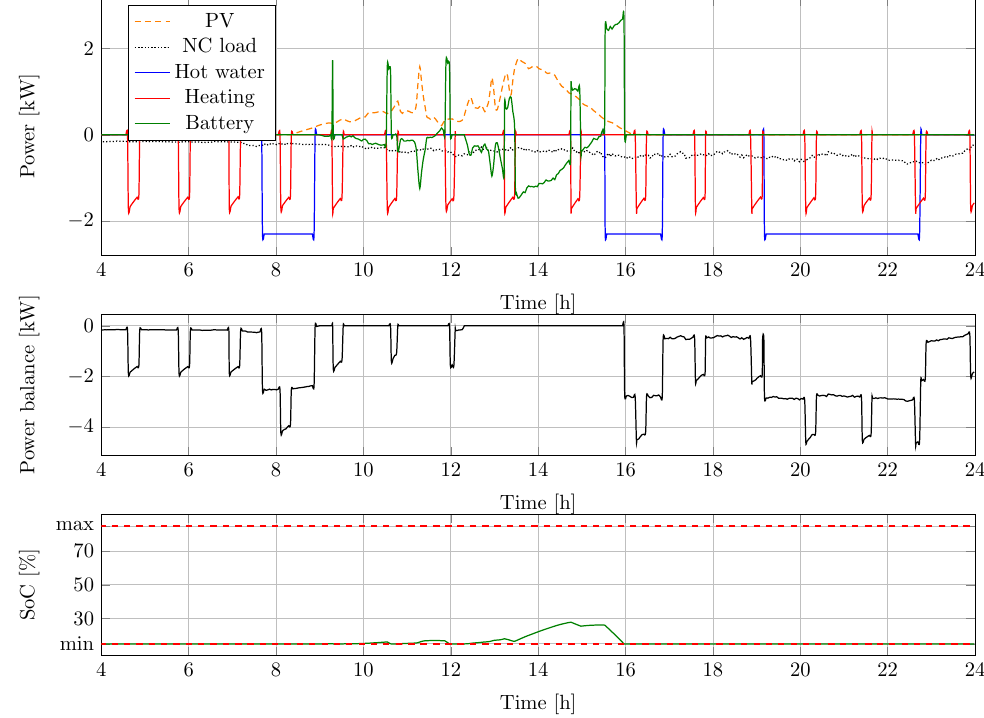
Figure 9. Power consumption/generation of devices for the winter cloudy day scenario. The upward and downward flexibility capabilities of each device were added, result- ing in the building’s maximum flexible power (Figure